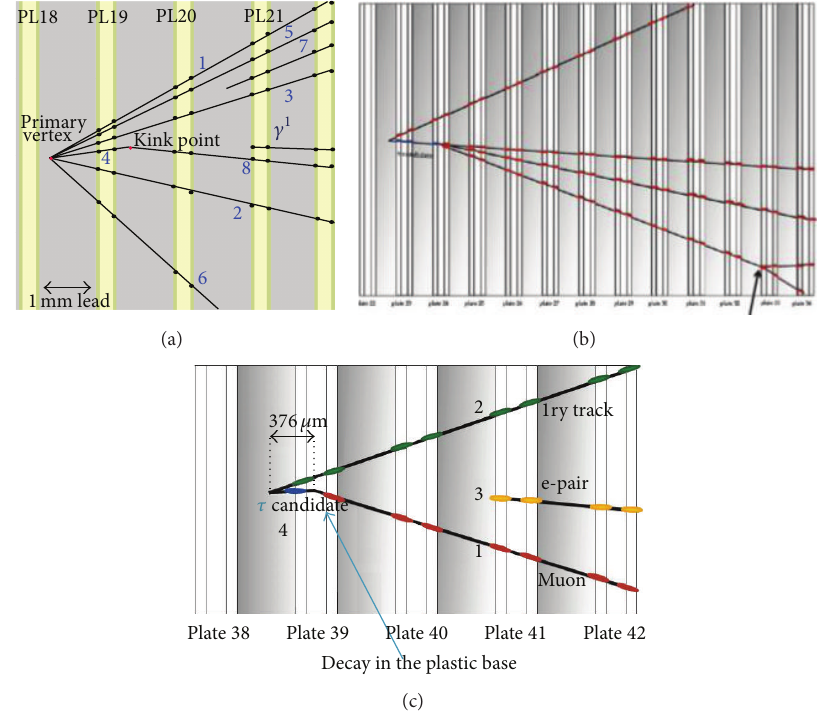
Figure 14: Display of three ] 𝜇 → ] 𝜏 candidate events from the OPERA experiment. (a) First event ] 𝜇 → 4ℎ + ] 𝜏 , 𝜏 → 𝑒 − + 𝜋 ∘ , (b) second event ] 𝜇 → ℎ + ] 𝜏 , ] 𝜏 → 3ℎ , and (c) third event ] 𝜇 → ℎ + ] 𝜏 , ] 𝜏 → 𝜇 .